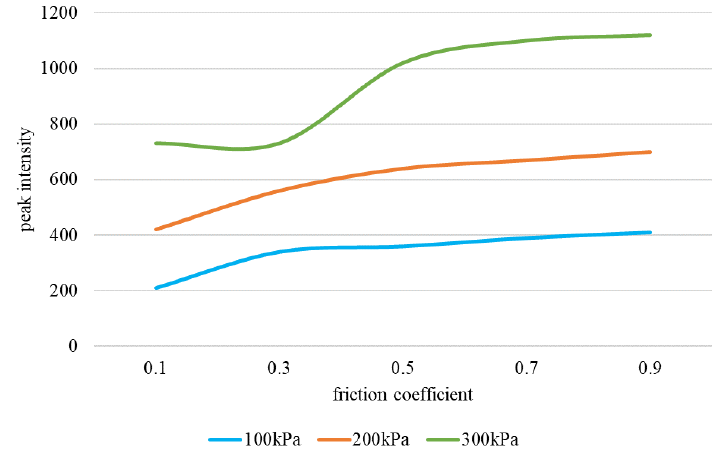
Figure 6. Relationship between particle friction coefficient and peak strength.